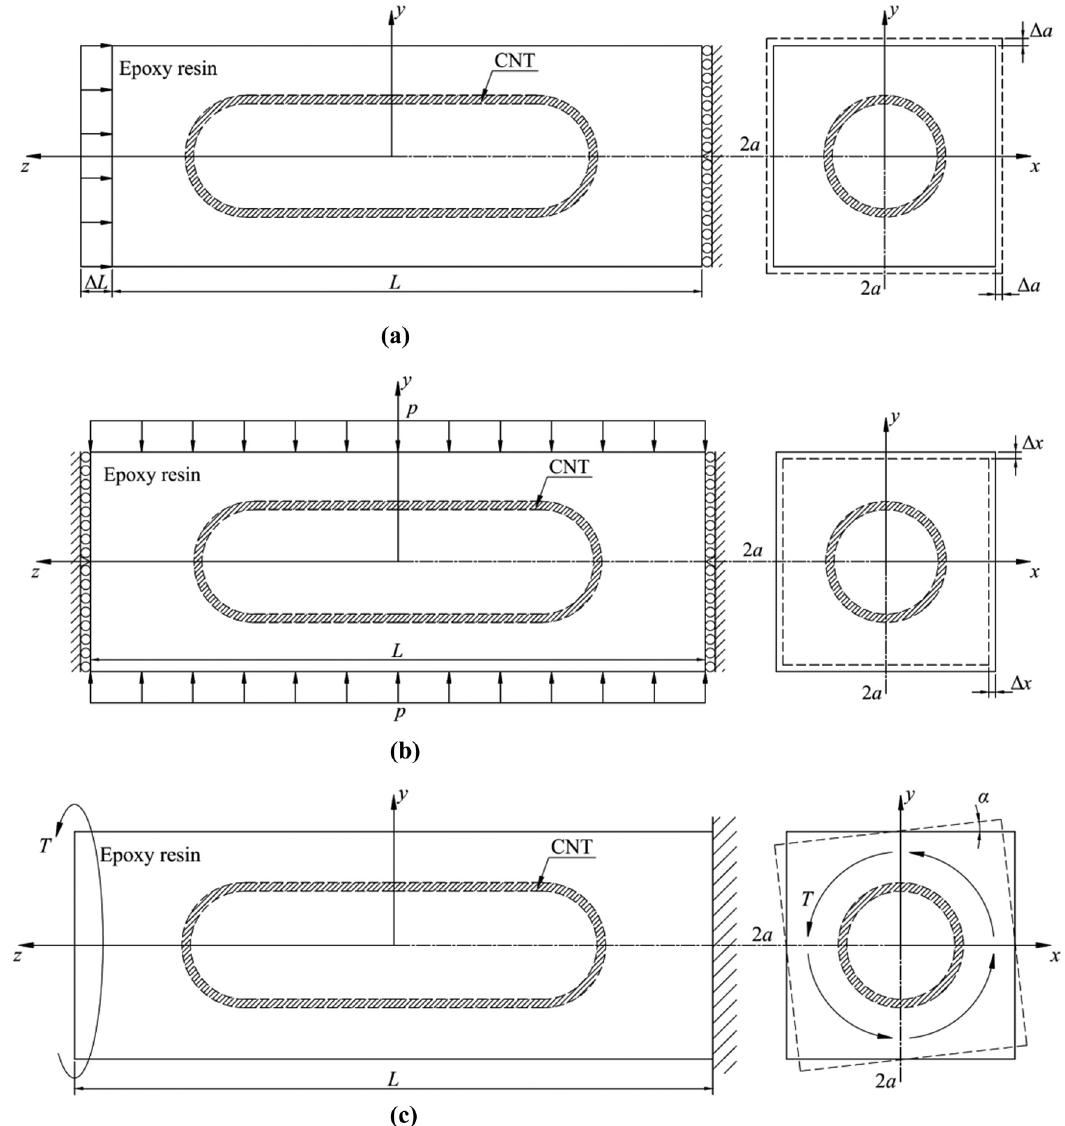
Figure 11: RVE containing a single CNT under di ff erent load conditions ( left: front view and right: side view ) : ( a ) uniaxial compression, ( b ) lateral contraction, and ( c ) axial torsion.